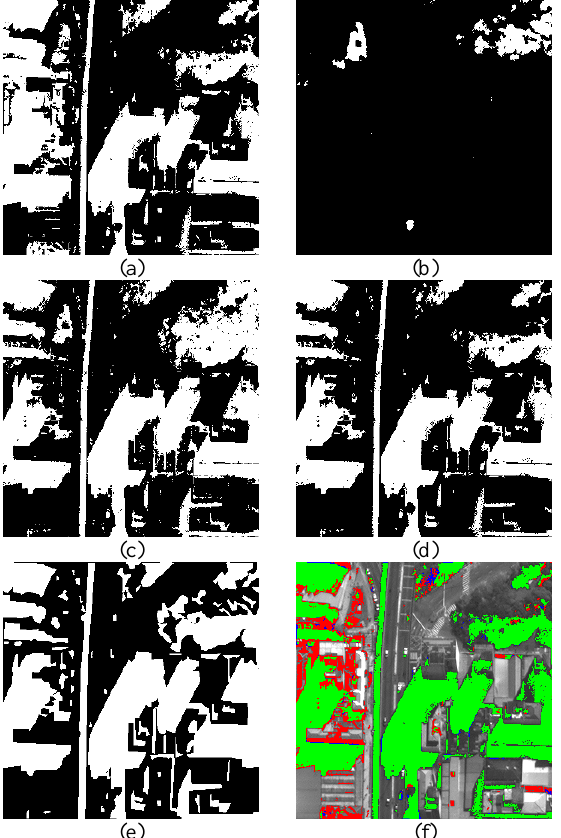
Fig. 3. Image 1 binary results for comparison. (a) First approach result; (b) NDVI mask; (c) NSDVI results; (d) Third approach result; (e) GT; (f) Comparison between (a, d, e).